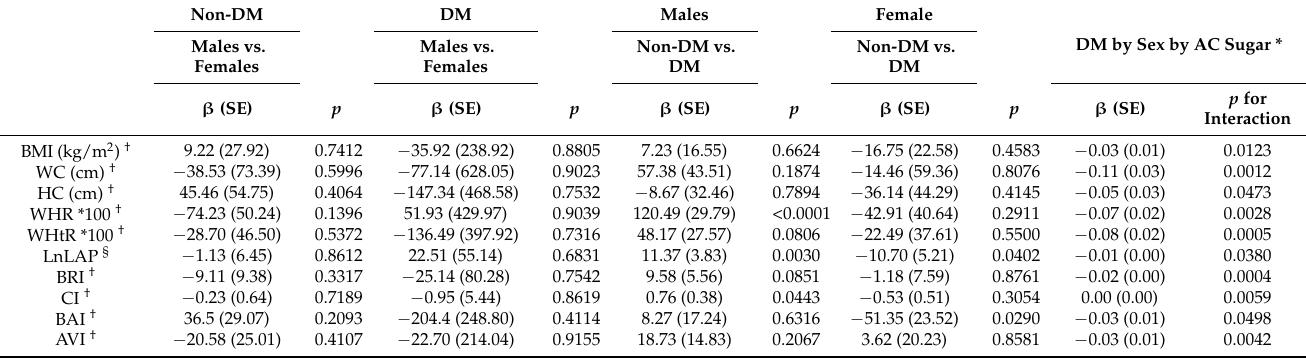
Table 2. B-spline comparisons for DM by sex or sex by DM in AC sugar levels with obesity-related